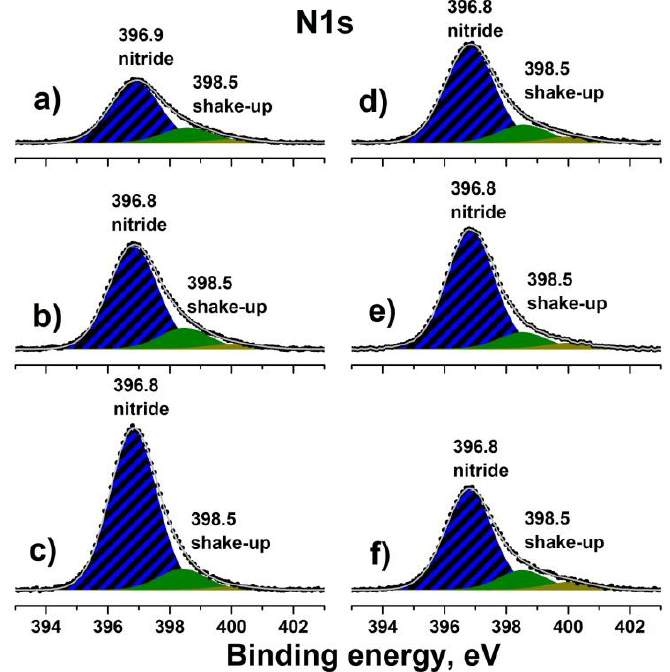
Figure 5. N1s XP-spectra obtained for Ti-Al-N films ( a ) 200 ◦ C, 20 sccm; ( b ) 200 ◦ C, 40 sccm; ( c ) 200 ◦ C, 60 sccm, ( d ) 500 C, 20 sccm, ( e ) 500 C, 40 sccm and ( f ) 500 C, 60 sccm after Ar + ion etching.